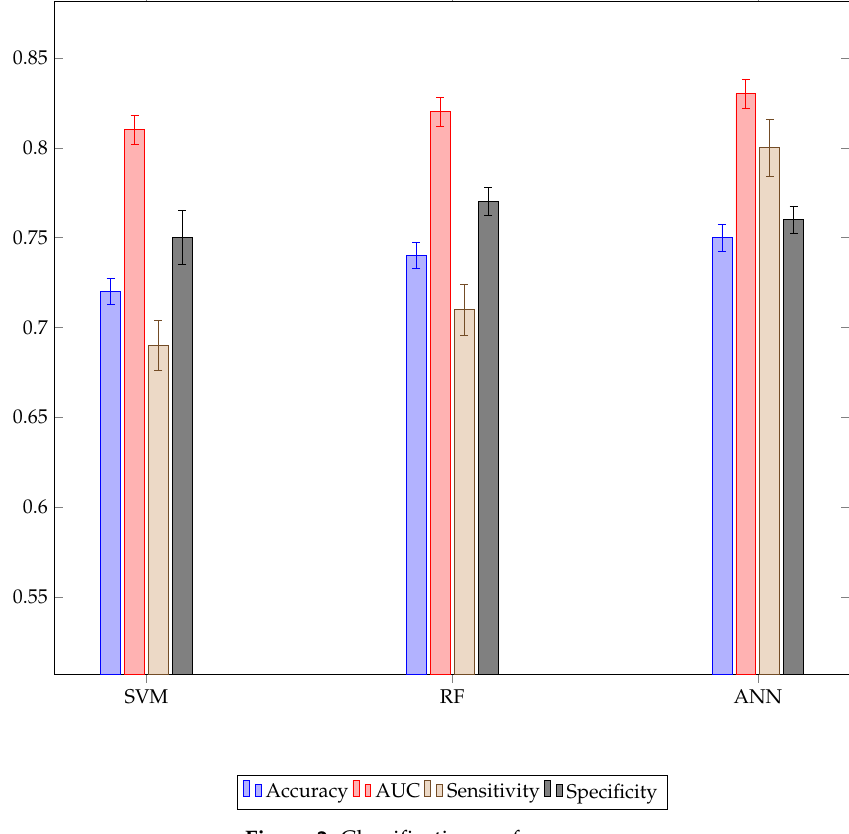
Figure 2. Classification